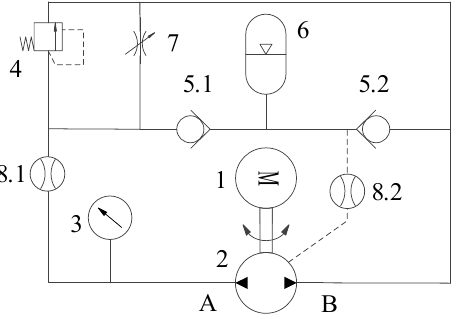
Figure 10. Experimental hydraulic schematic diagram of load zone. 1: servomotor; 2: positive displacement pump; 3: pressure gauge; 4: relief valve; 5.1/5.2: check valve; 6: accumulator; 7: throttle valve; 8.1/8.2: flow sensor.